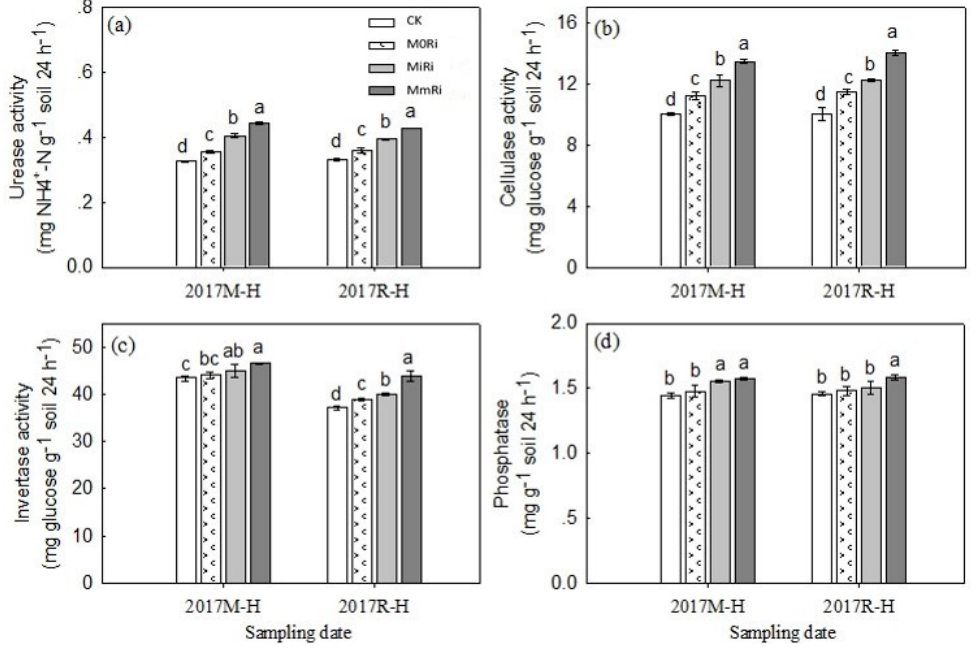
Figure 4. Changes in ( a ) soil urease, ( b ) soil cellulase, ( c ) soil invertase, and ( d ) soil phosphatase activities in the 0–20 cm soil layer under different treatments in 2017. M-H, maize harvest, R-H, rice harvest. Bars with different lower case letters indicate significant differences at p < 0.05.